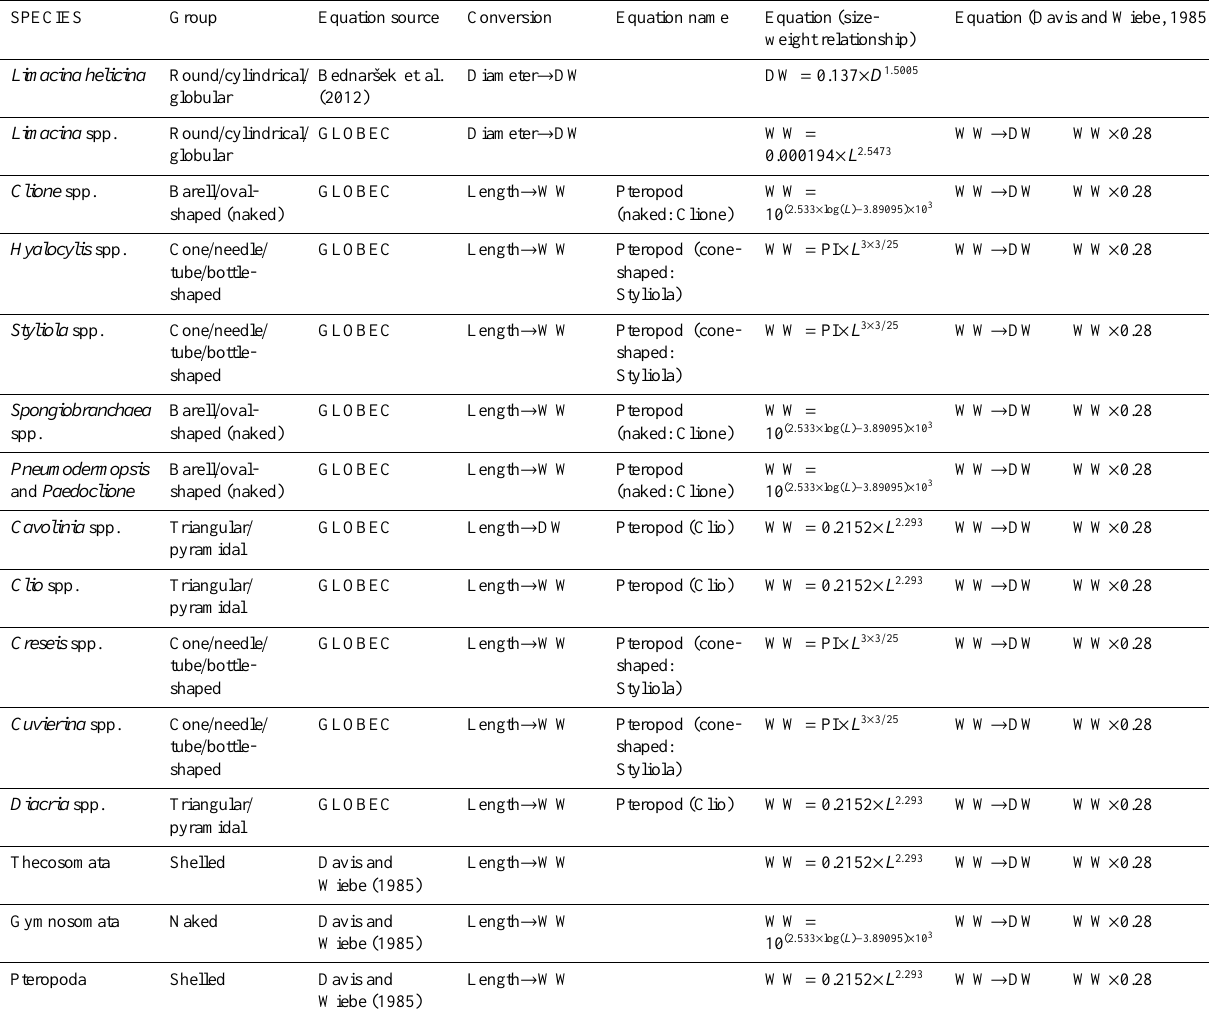
Table 2. Length to weight equations for di ff erent pteropod groups based on the geometric shapes. SPECIES Group Equation source Conversion Equation name Equation (size- Equation (Davis and Wiebe, 1985) weight relationship) Bednarˇsek et al. Limacina helicina Round / cylindrical / Diameter → DW DW = 0.137 × D 1 . globular (2012)